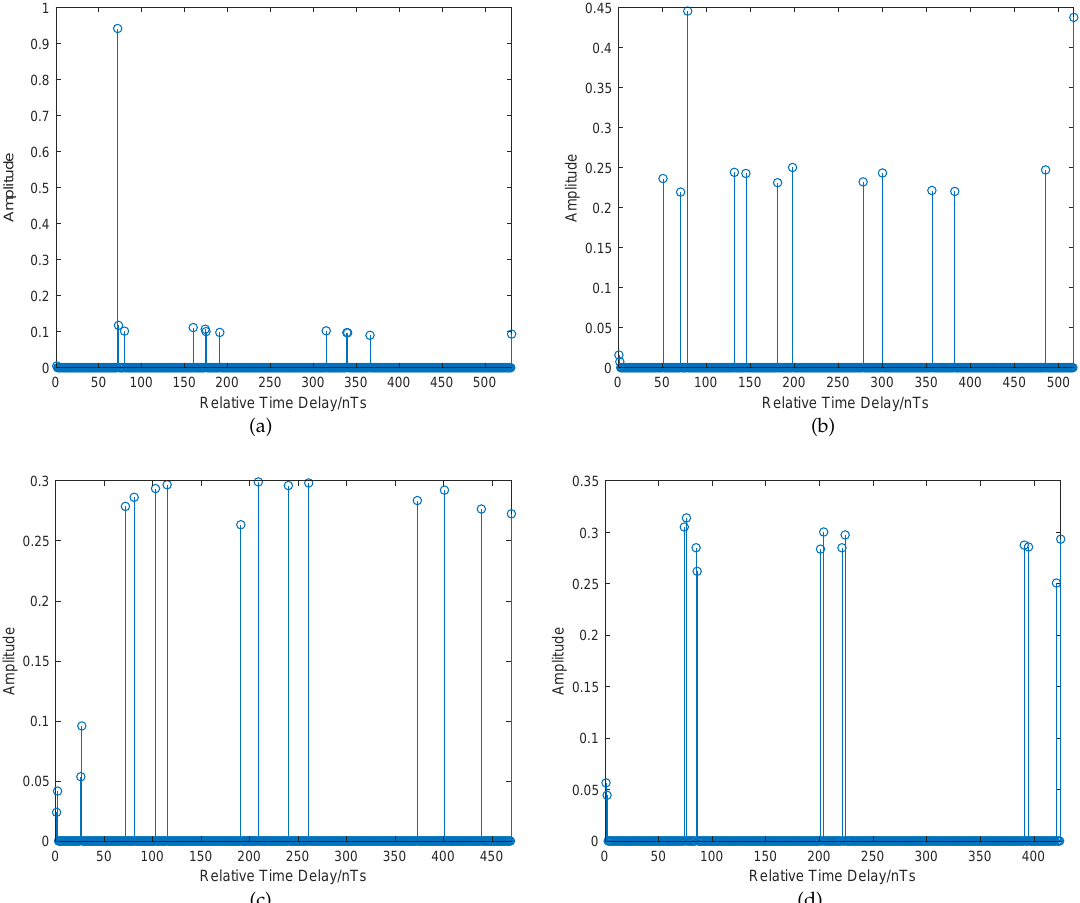
Figure 7. Normalized channel impulse responses (CIRs) of channel with different receiving depth. Receiving depth of each figure: ( a ) 10 m; ( b ) 30 m; ( c ) 50 m; ( d ) 70